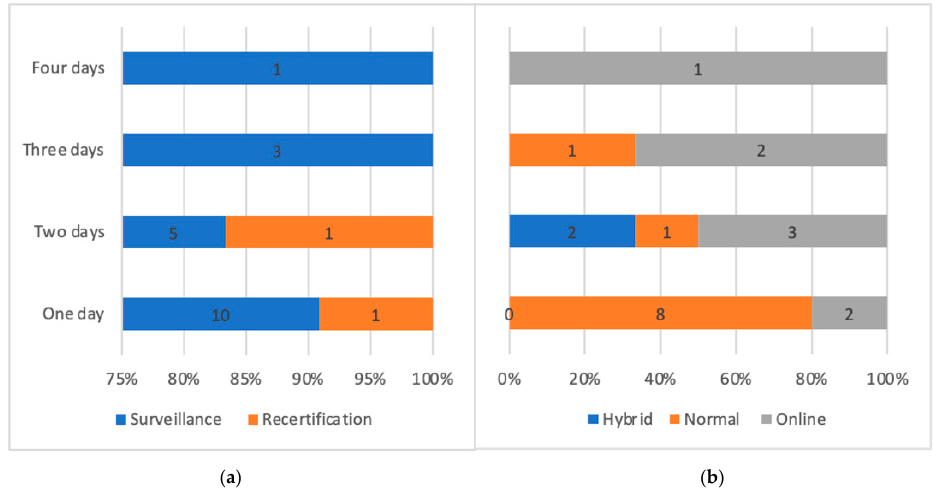
Figure 1. Number of companies distributed by number of auditing days: ( a ) audit type; ( b ) audit sys-